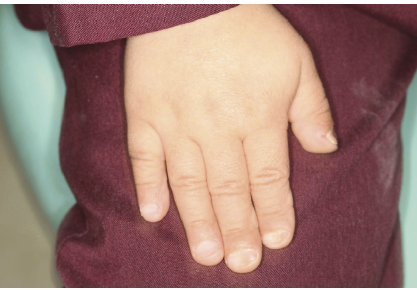
Figure 1: Abnormalities in the fingers and skin in a patient suf- fering from PDO.